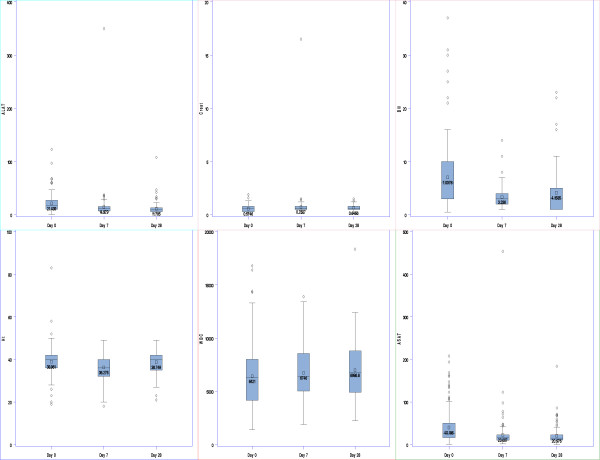
Boxplots of laboratory parameters over time. (ALT = aspartate transaminase; ALT = alanine transaminase).